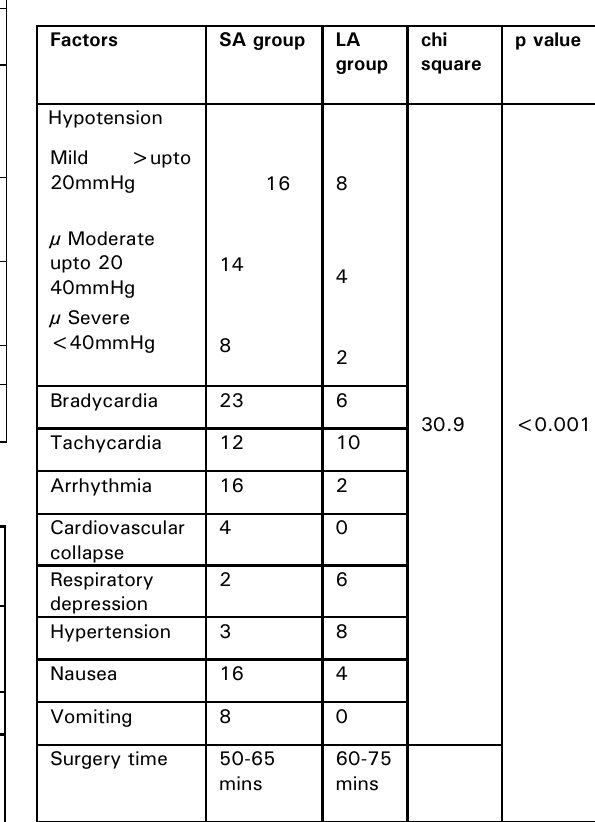
TABLE 4: Perioperative complications One of the most striking features of the study was statistically significant increase in the incidence of perioperative complications in SA group. (Table